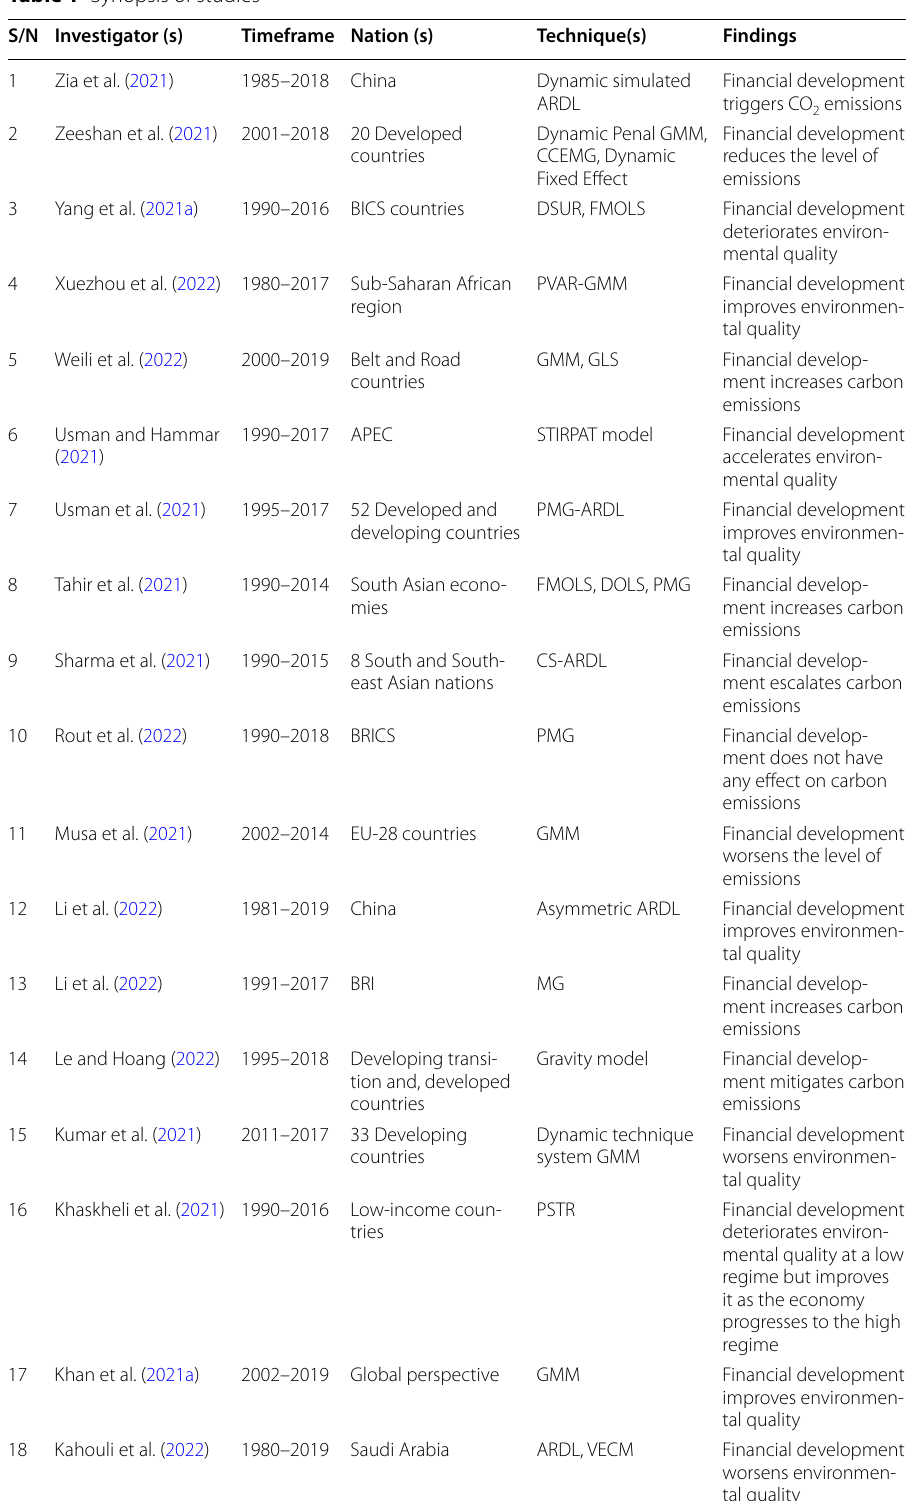
Table 1 Synopsis of